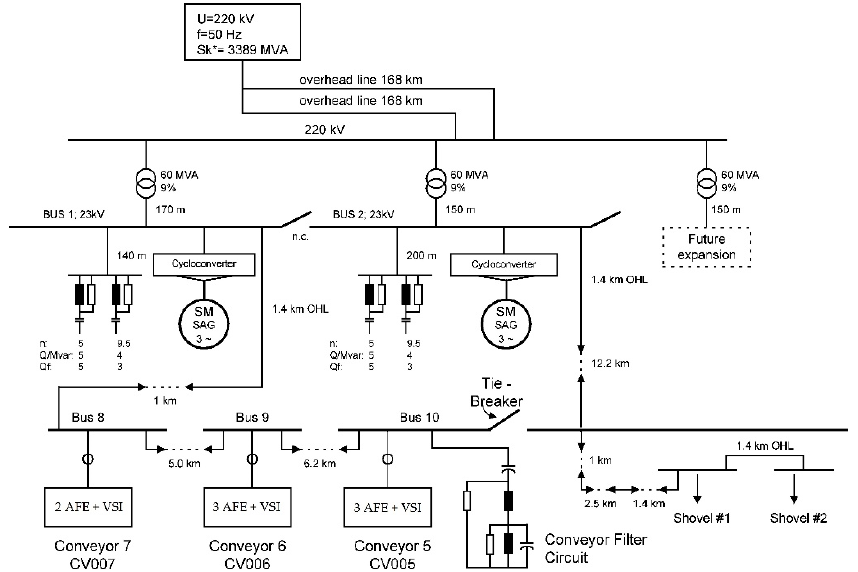
Figure 18. Simplified single-line diagram for the power grid of the Los Pelambres mine.